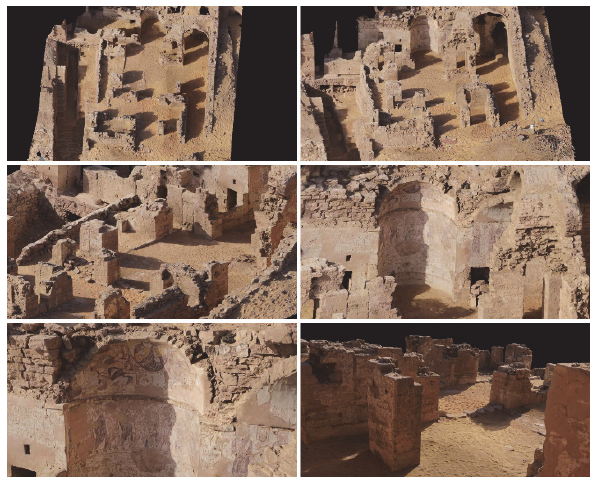
Figure 6. Views of the 3D model of the Coptic Church.